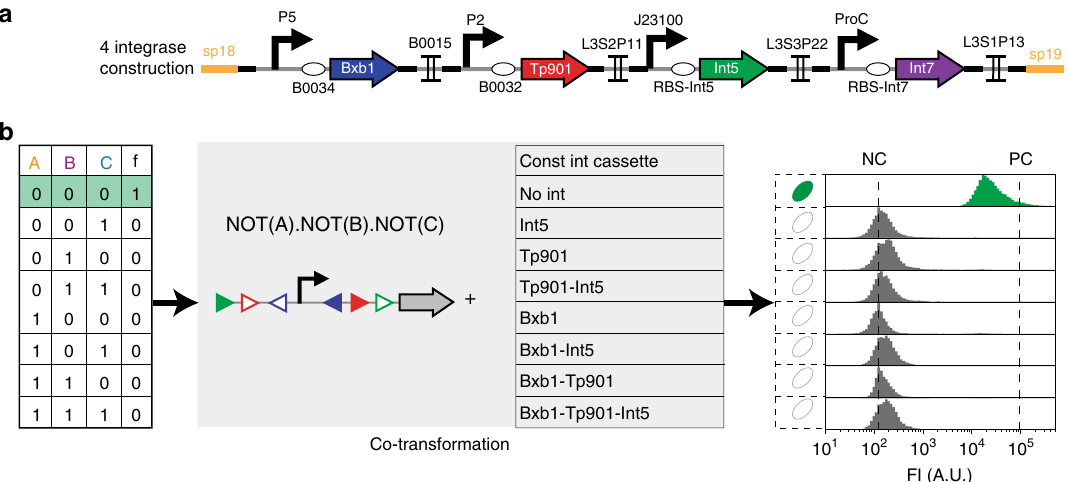
Fig. 3 Characterization of recombinase logic devices using constitutive integrase expression cassettes. a Architecture of the constitutive integrase expression plasmid. Each integrase is driven by a different promoter and RBS. Individual integrase expression cassettes are separated by transcriptional terminators. The 4 integrase generator plasmid is represented here. We generated all possible integrase combination for a total of 16 plasmids (see Supplementary Fig. 5 for characterization data). P promoter, RBS Ribosome Binding Site, Int integrase. b We characterized recombinase logic devices response for each input state by co- transforming each device with our combinatorial collection of constitutive integrase cassettes (see materials and methods for details). FI: fl uorescence intensity